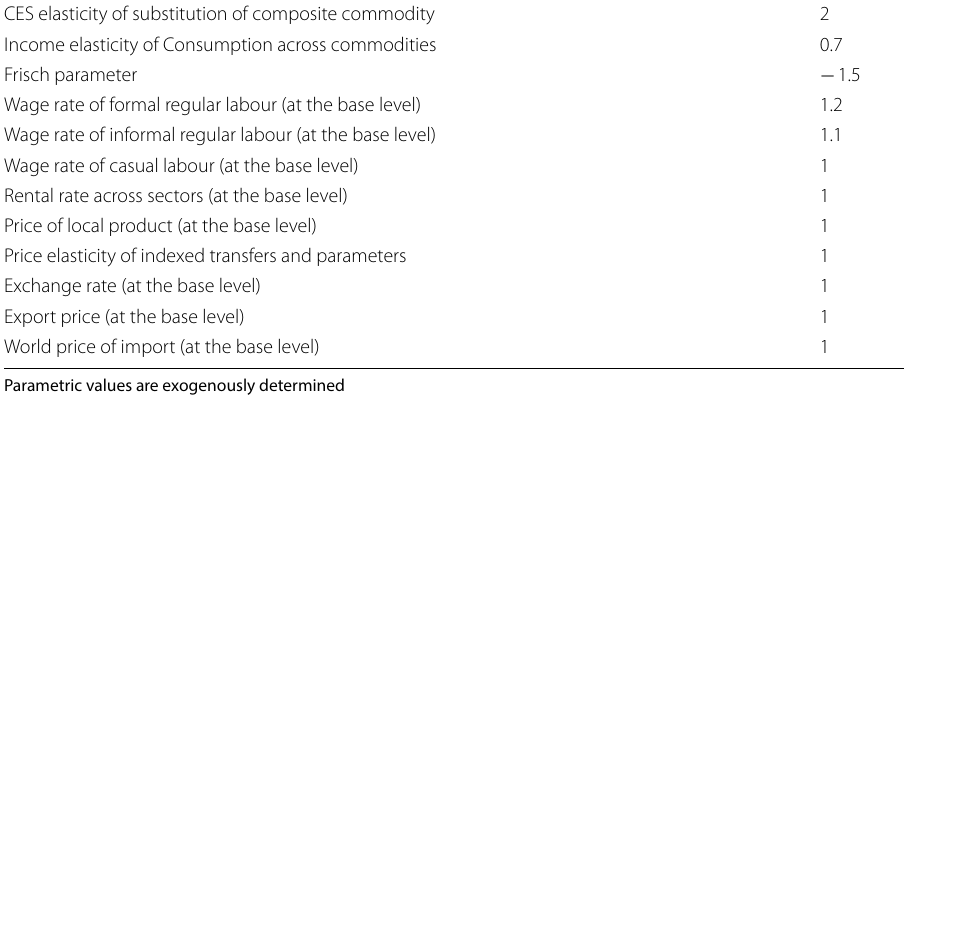
Table 16 Values of relevant parameters Description of elasticity parameters CES elasticity of substitution of composite